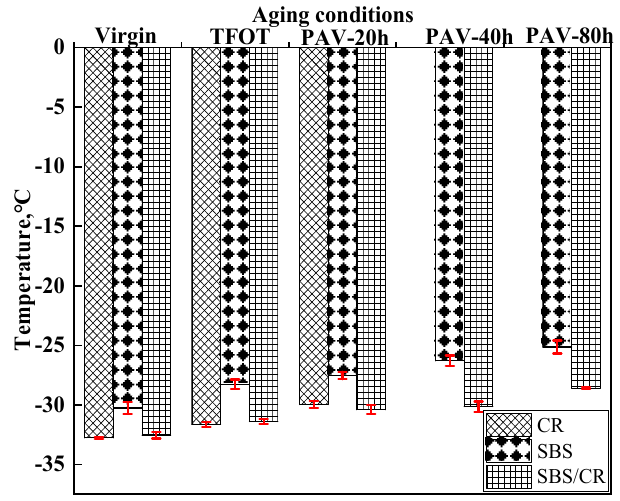
Figure 9. PG Low temperature of all tested binders.